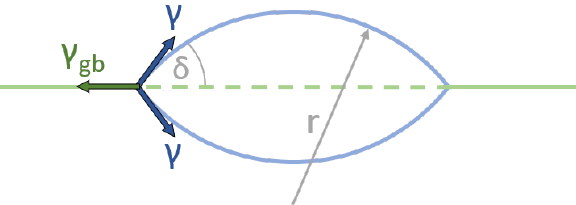
Figure 3. Schematic shape of a cavity at a grain boundary (green line).